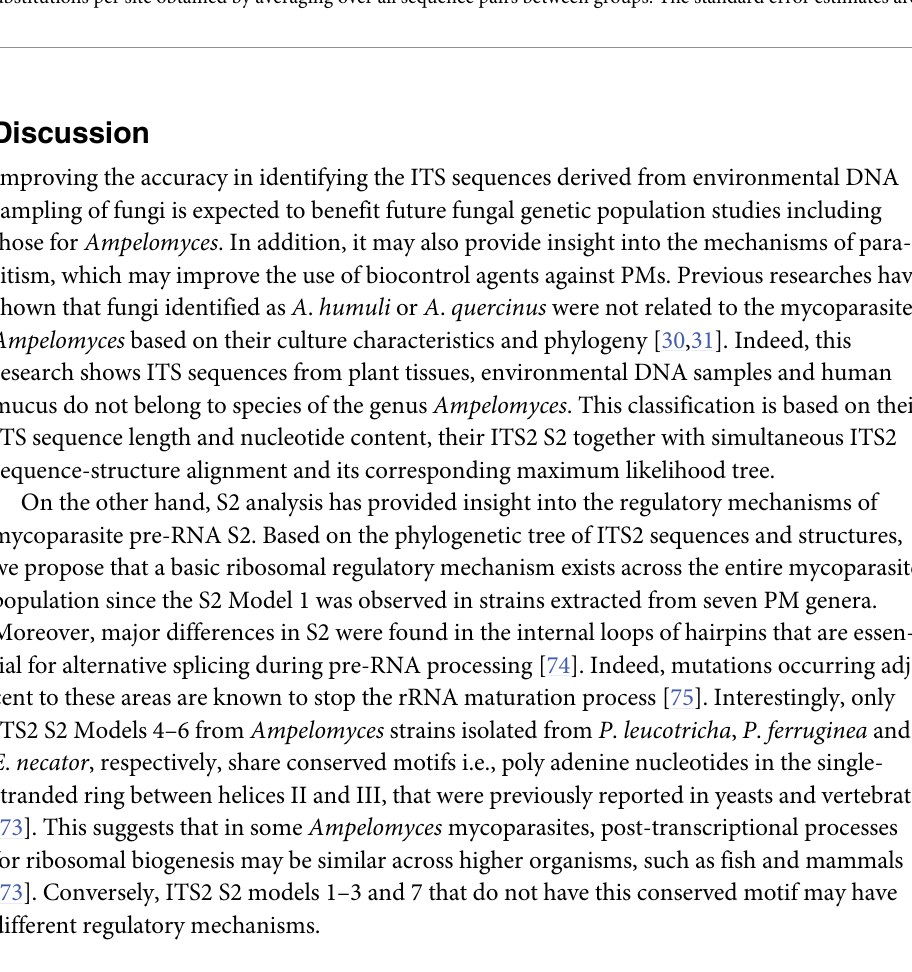
Table 5. Estimates of evolutionary divergence over sequence pairs between fungal groups when analysing the ITS region. ITS 1